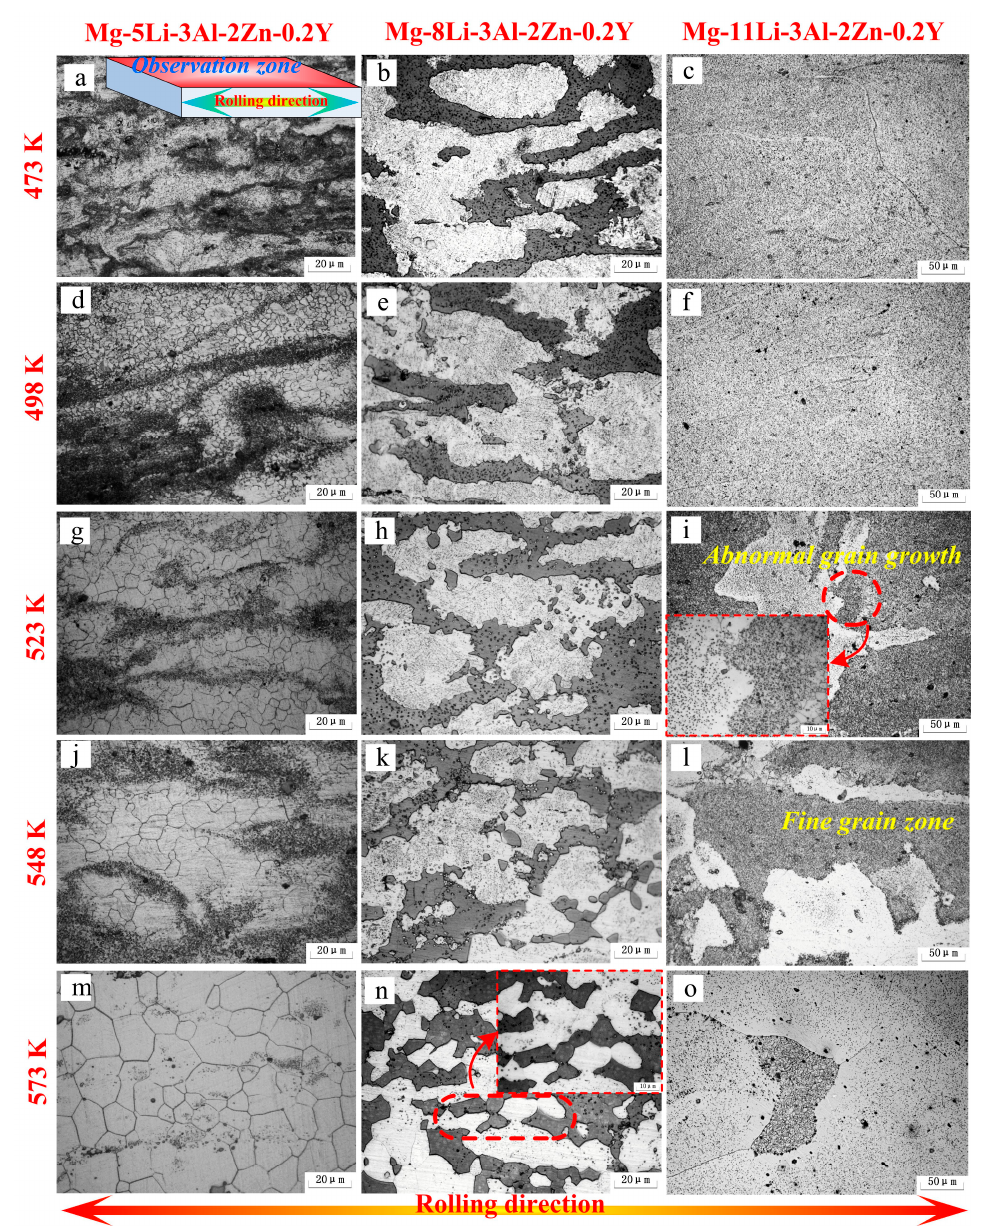
Figure 5. Microstructures of the as-rolled alloys annealed at different temperatures for 24 h.